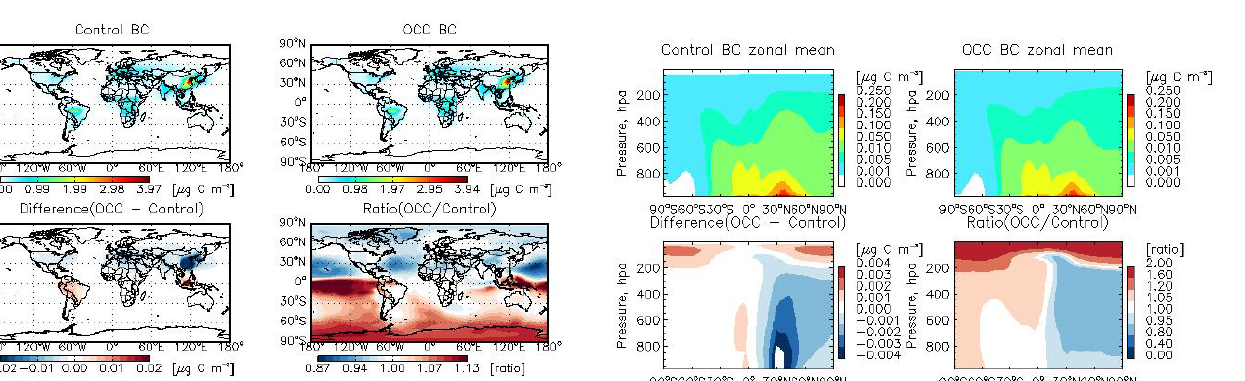
Fig. 6b. Same as Fig. 6a but for OC.